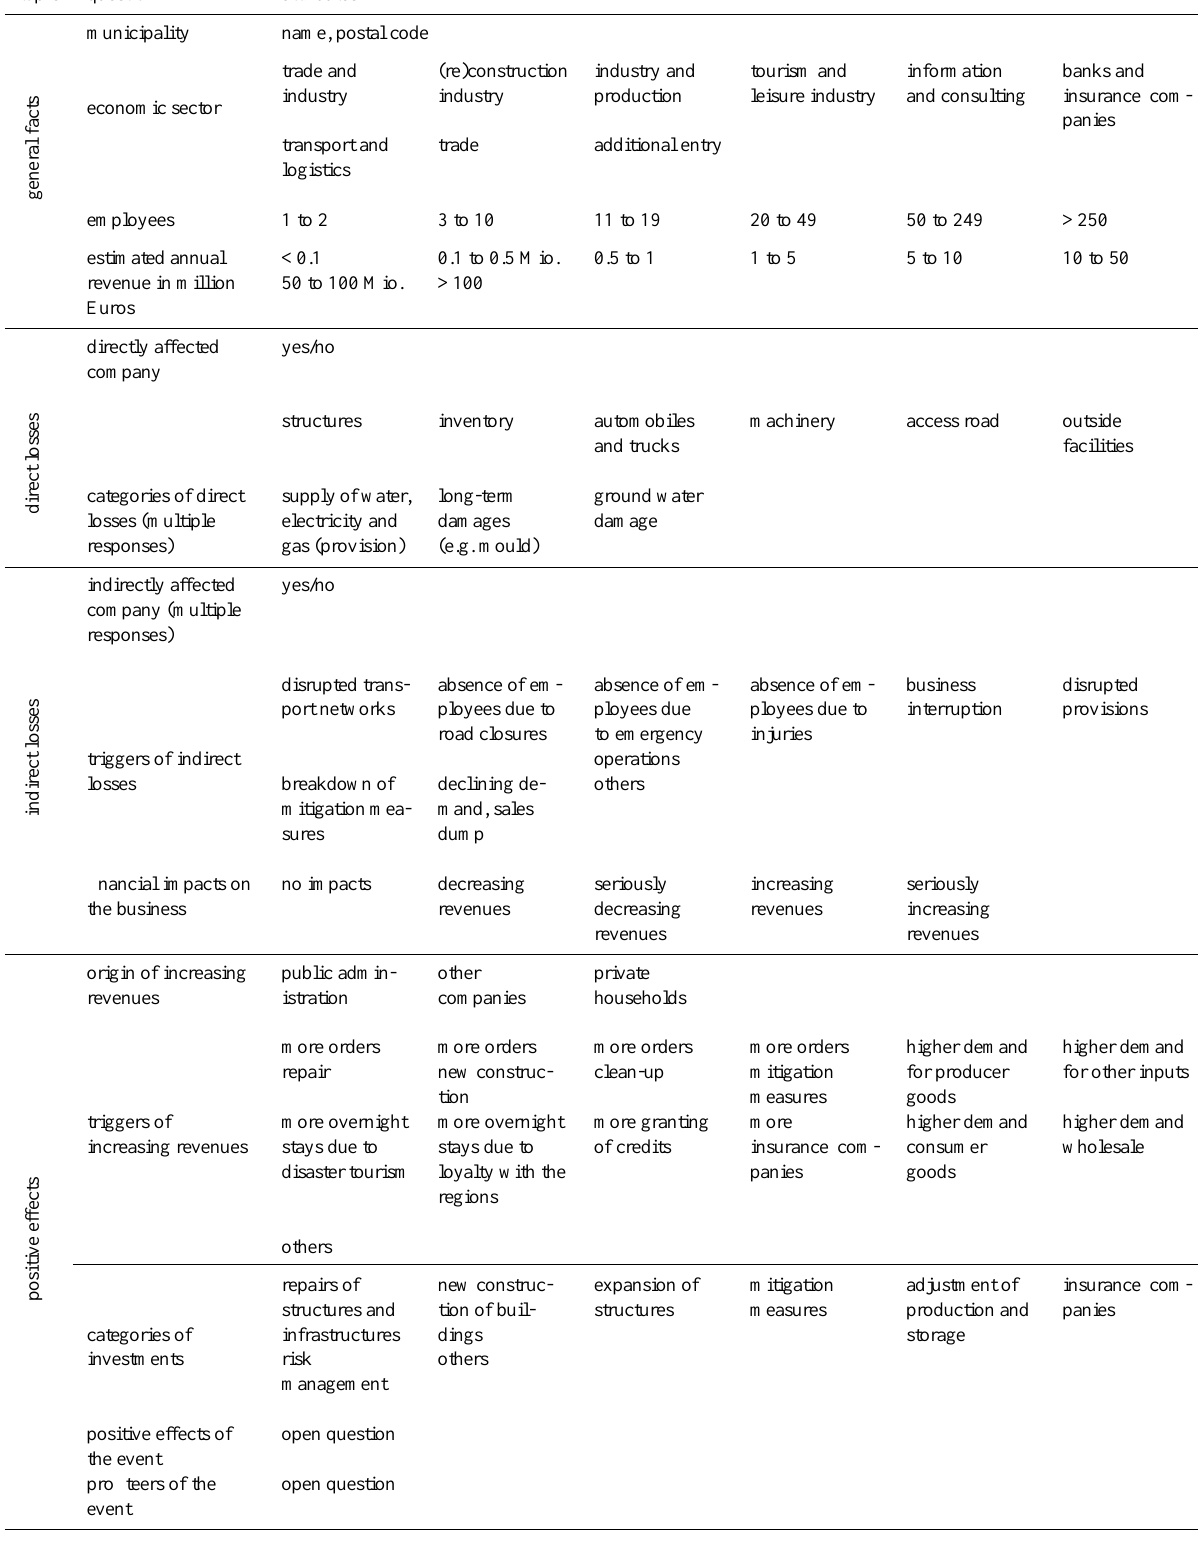
Table A1. Overview of questionnaire topics and